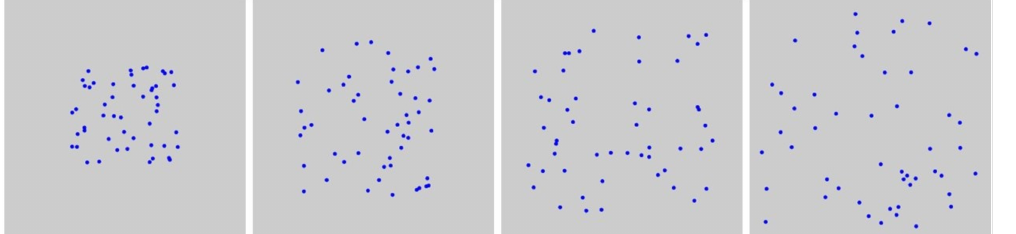
Figure 7. Examples of random feature point locations on the left camera image (the proportion of the image is 20%, 40%, 60%, and 80%).